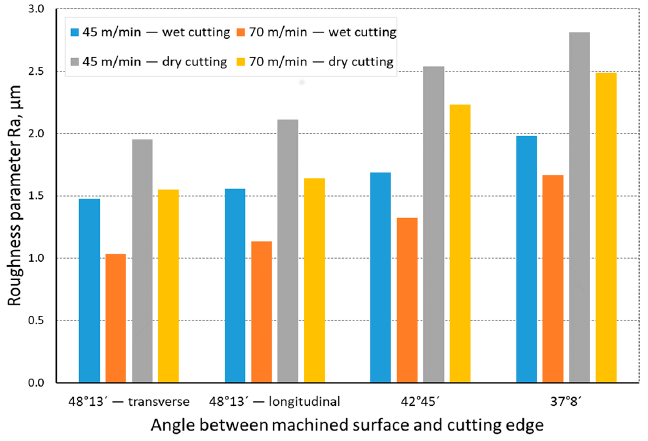
Figure 5. The impact of cutting speed on the variability of roughness parameter Ra in the function of the angle between the machined surface and cutting edge for a rectilinear track and a material hardness of 36 HRC.